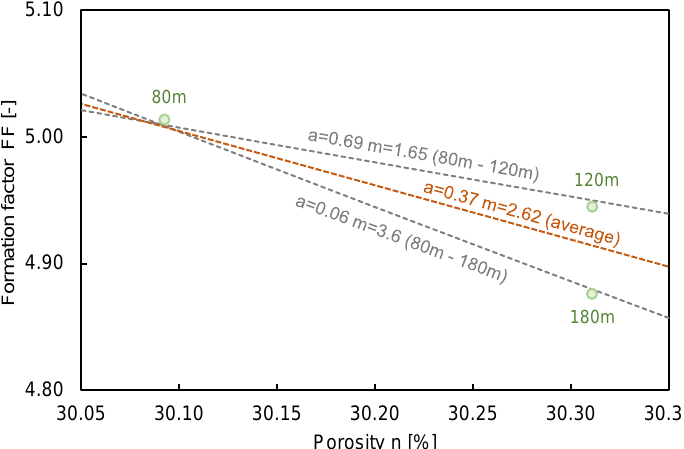
Figure 10. Relationship between the formation factor and porosity for the extracted specimens. Here, a and m denote the tortuosity and cementation factors.